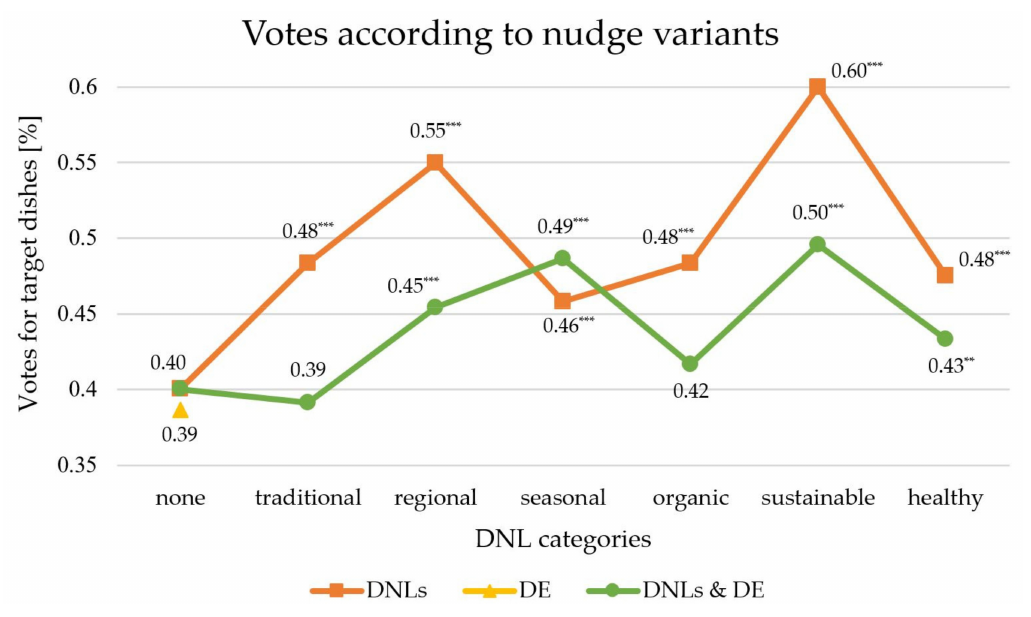
Figure 3. Descriptive results of Study II—DNLs, DE and DNLs and DE. Note: *** p < 0.001, ** p < 0.01, * p < 0.05 (pairwise t -test). The single decoy e ff ect (DE) has only one data point in the “none”